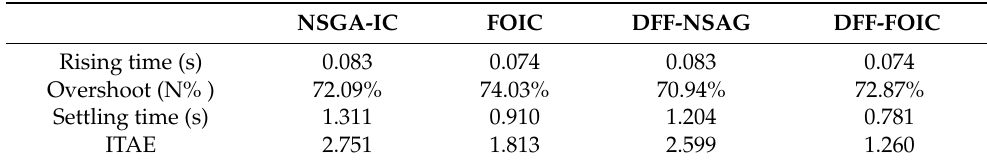
Figure 22. Performance comparison of FOIC, DFF-FOIC, NSGA-IC and DFF-NSGA-IC. Table 12. Force step response performance comparison of FOIC, DFF-FOIC, NSGA-IC, and DFF-